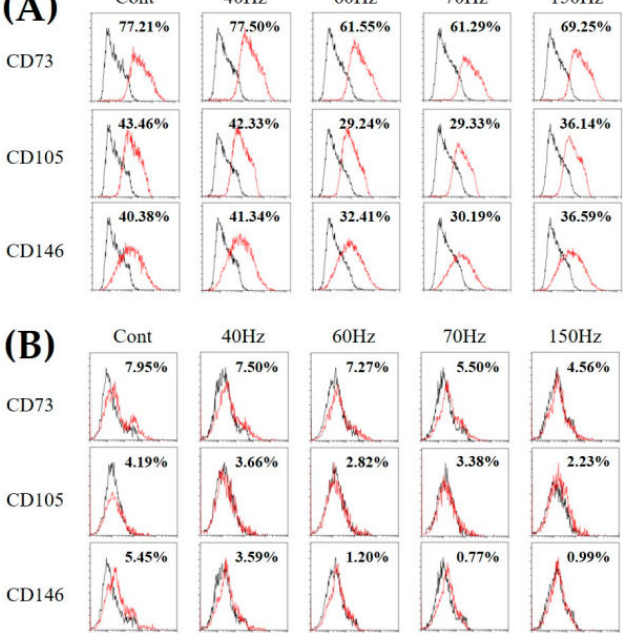
Figure 3. Fluorescence-activated cell sorter analysis of the surface markers CD73, CD105, and CD146 after PEMF exposure for 5 days ( A ) and 10 days ( B ). hDPSCs were labeled with phosphatidylethanolamine-conjugated antibodies and then analyzed in a flow cytometer. hDP- SCs; human dental pulp stem cells. Cont = control (no PEMF treatment). Black line: FITC- or PE-conjugated IgG1, Red line: FITC- or PE-conjugated